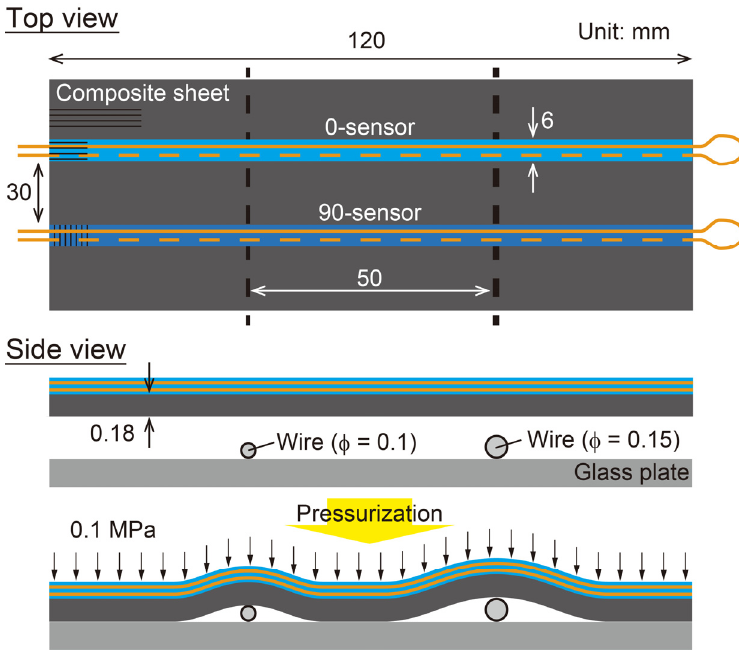
Figure 7. Schematic of experiment setup for sensor response validation.